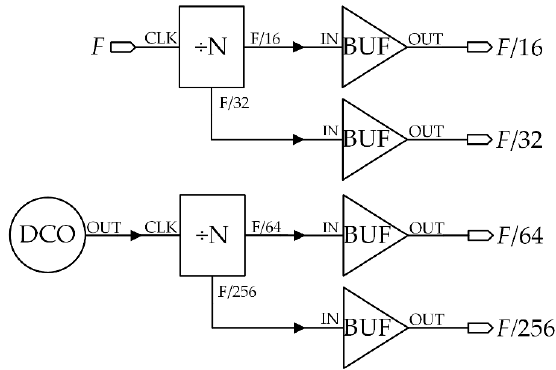
Figure 3. Simplified block diagram of the proposed LC DCO and frequency divider. DCO—digitally controlled oscillator, ÷N—frequency divider, BUF—output buffer, F —frequency divider input signal, F/N —frequency divider signal frequency divided by coefficient N.